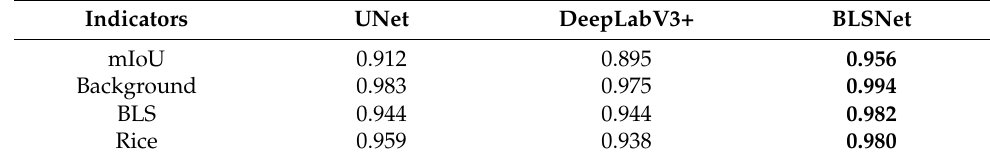
Table 2. Accuracy comparison of the proposed BLSNet model with UNet and DeepLabV3+. Indicators UNet